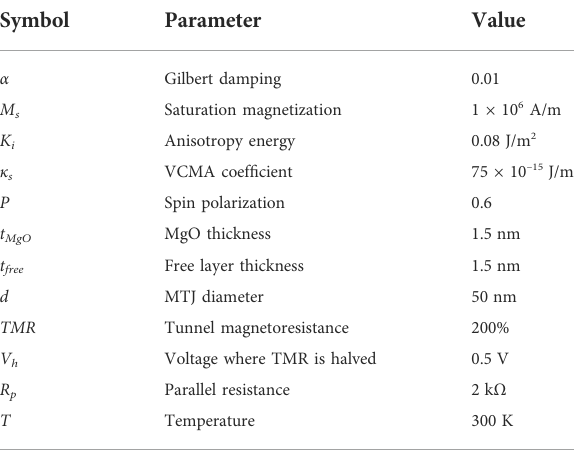
TABLE 2 Physical parameters used in micromagnetics simulations of the